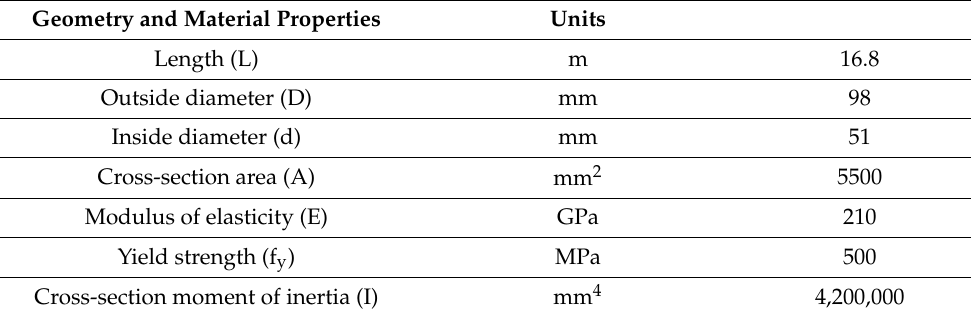
Table 2. Geometrical and mechanical characteristics of Titan 105/51 hollow bars for piles. Geometry and Material